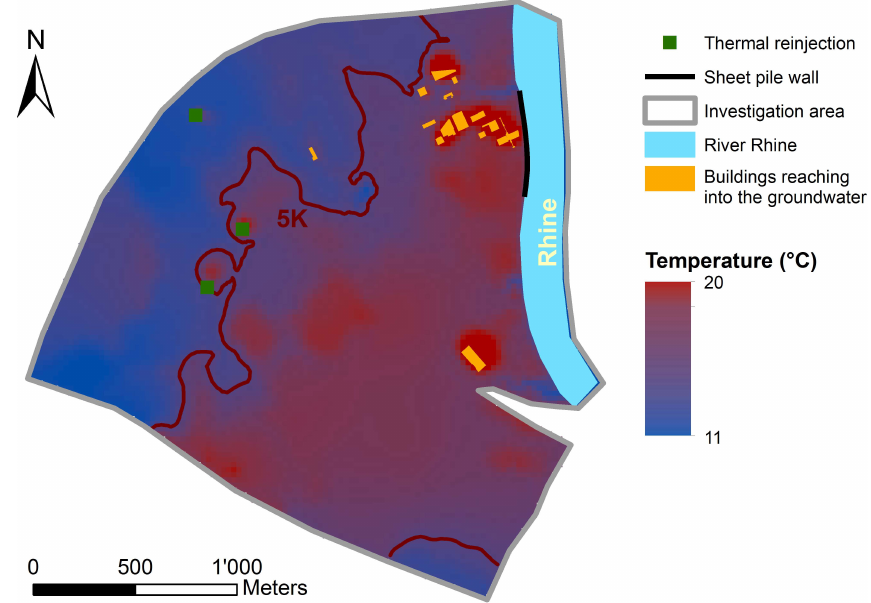
Fig. 10. Calculated temperature distribution for winter 2010/2011 under consideration of future urbanization (for locations see Fig. 1). Delineation of areas with temperature increases > 5K compared to a “potential natural” state (for explanation refer to the